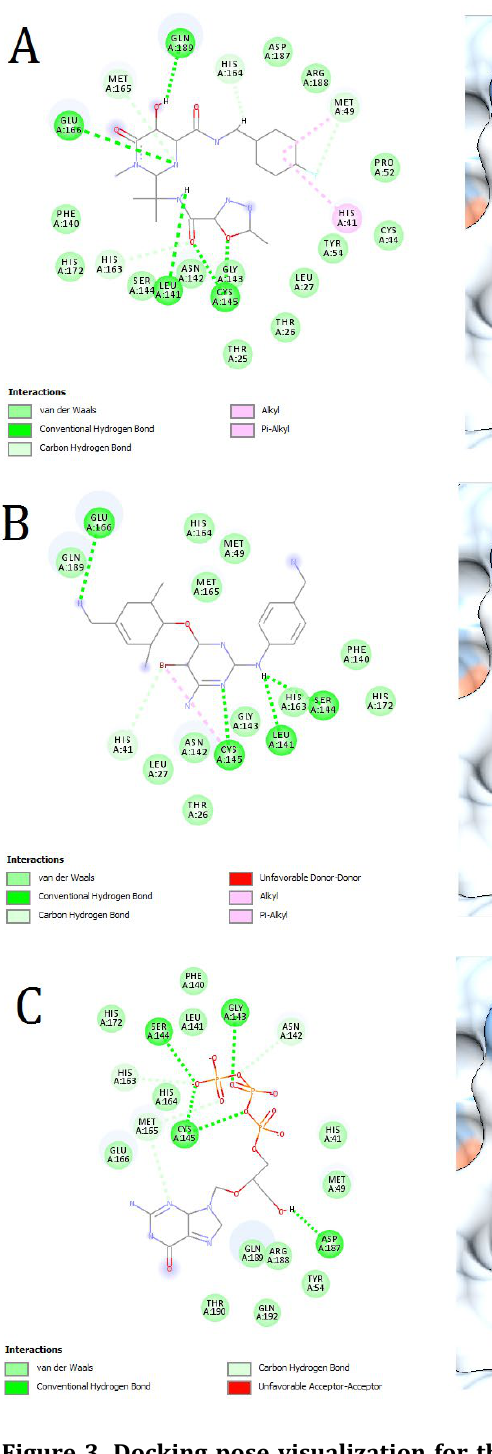
Figure 3. Docking pose visualization for the drugs with the best predicted results (Right) and their 2D receptor-ligand interaction diagram